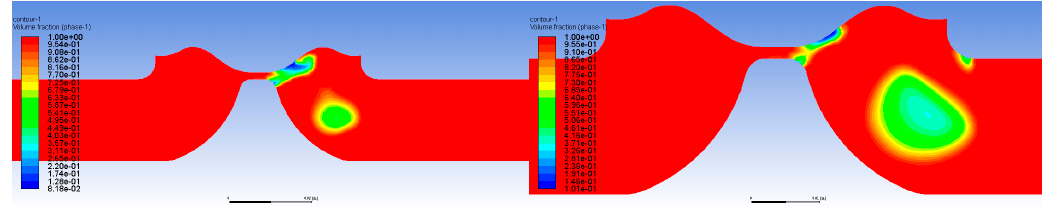
Figure 16. Volume fraction nephogram at different inlet pressures.